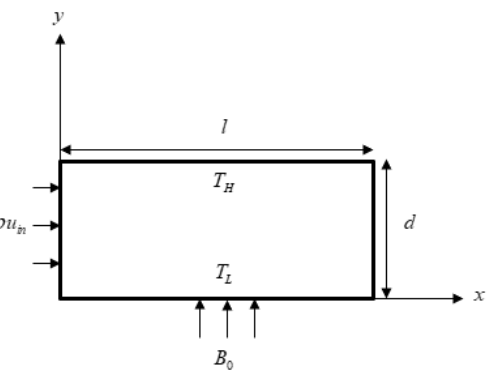
Figure 1. Schematic representation of the physical geometry of the problem.